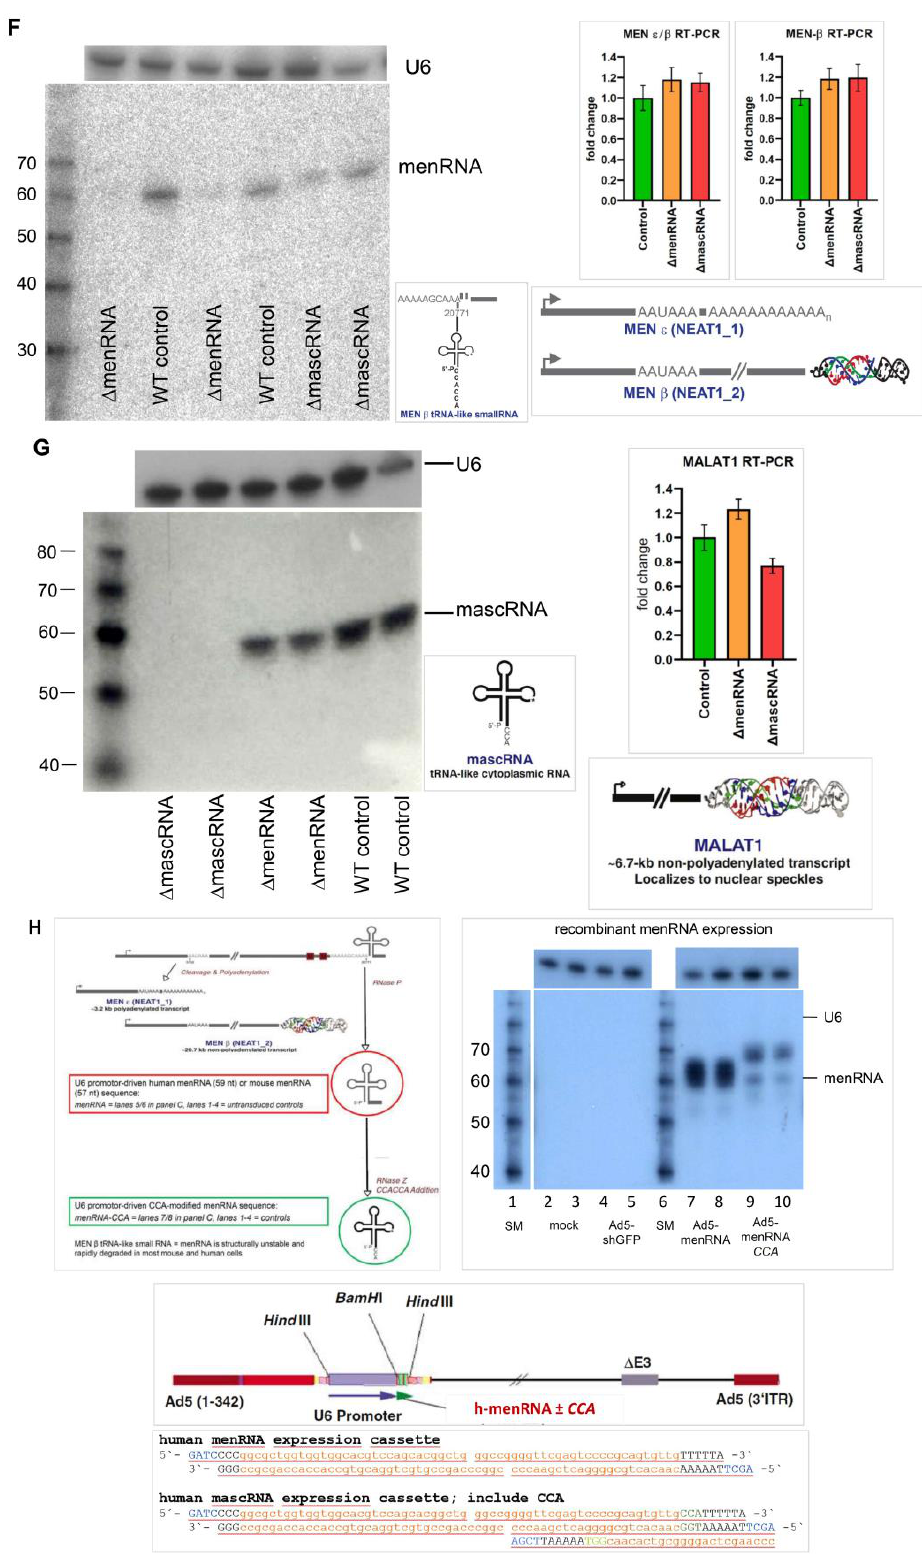
Figure 1. Targeted disruption of tRNA-like transcripts in the NEAT1-MALAT1 gene cluster. Panel ( A ): The NEAT1-MALAT1 gene cluster encodes two primary transcripts which are subsequently processed to transcripts of vastly different size. The NEAT1 locus yields the 23 kb MEN- β (NEAT1_1) and 3.7 kb MEN- ε (NEAT1_2). Of note, the long MEN - β transcript forms an unusual triple helix structure at its 3′ -end which has been shown to stabilize this long transcript. From the primary transcript, an additional short tRNA- like 59 nt ‘menRNA’ is generated through RNAse P and Z enzymatic cleavage. Panel ( B ): The MALAT1 locus yields a 8.3 kb primary transcript also forms a stabilizing triple helix at the 3′ -end, and through enzymatic cleavage another small tRNA- like 59 nt ‘mascRNA’. Using CRISPR -Cas9, we developed human monocyte-macrophage cell lines with menRNA or mascRNA sequence deletions as indicated. Panel ( C ): The editing procedures oc- cur outside of the primary transcript sequences required for regular formation of the triple-helix structures at their 3′ -ends which support stabilization of the respective lncRNAs. The inset shows the functional domains of MEN- β as determined through CRISPR -Cas9 deletion mapping by Yama- zaki et al. [12] (by permission). This illustrates that the 57 nt deletion in the ΔmenRNA clone is located 21 nt 3‘ of the A - rich motif and RNaseP cleavage site generating the MEN β -stabilizing triple helix. Panel ( D ): From direct sequencing data of the ΔmenRNA THP-1 cell clone it is obvious that menRNA cannot be generated in these cells since almost the entire menRNA coding sequence is deleted. Importantly, repeat sequencing confirmed deletion of this same sequence in all subsequent cell passages used for the experiments reported in this manuscript (>25 passages) (shown are the